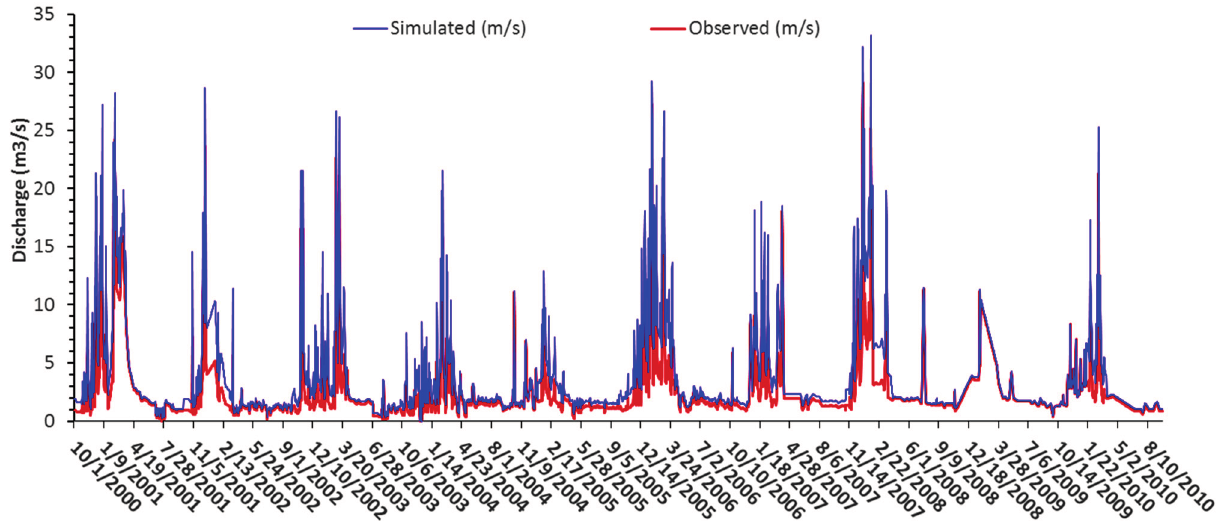
Figure 7. Observed and simulated streamflow for Mukuvisi catchment